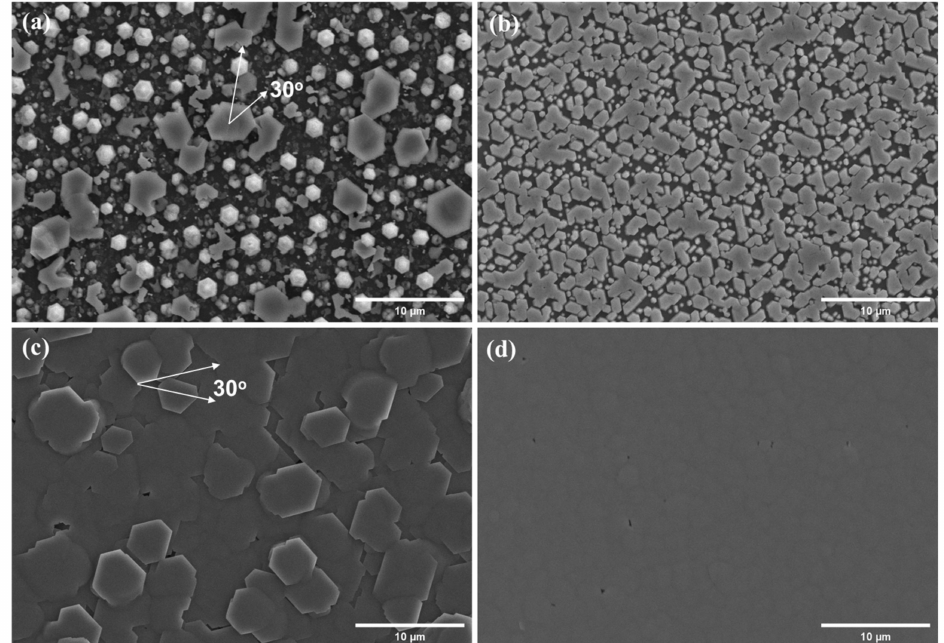
Figure 8. SEM images of ZnO seeds grown on as-cleaved mica substrates by Mist-CVD at 600 ◦ C for 30 min under ( a ) nitrogen (Type A) and ( b ) oxygen (Type B) ambient. Subsequent hydrothermal growth of continuous ZnO layers on ( c ) Type A and ( d ) Type B